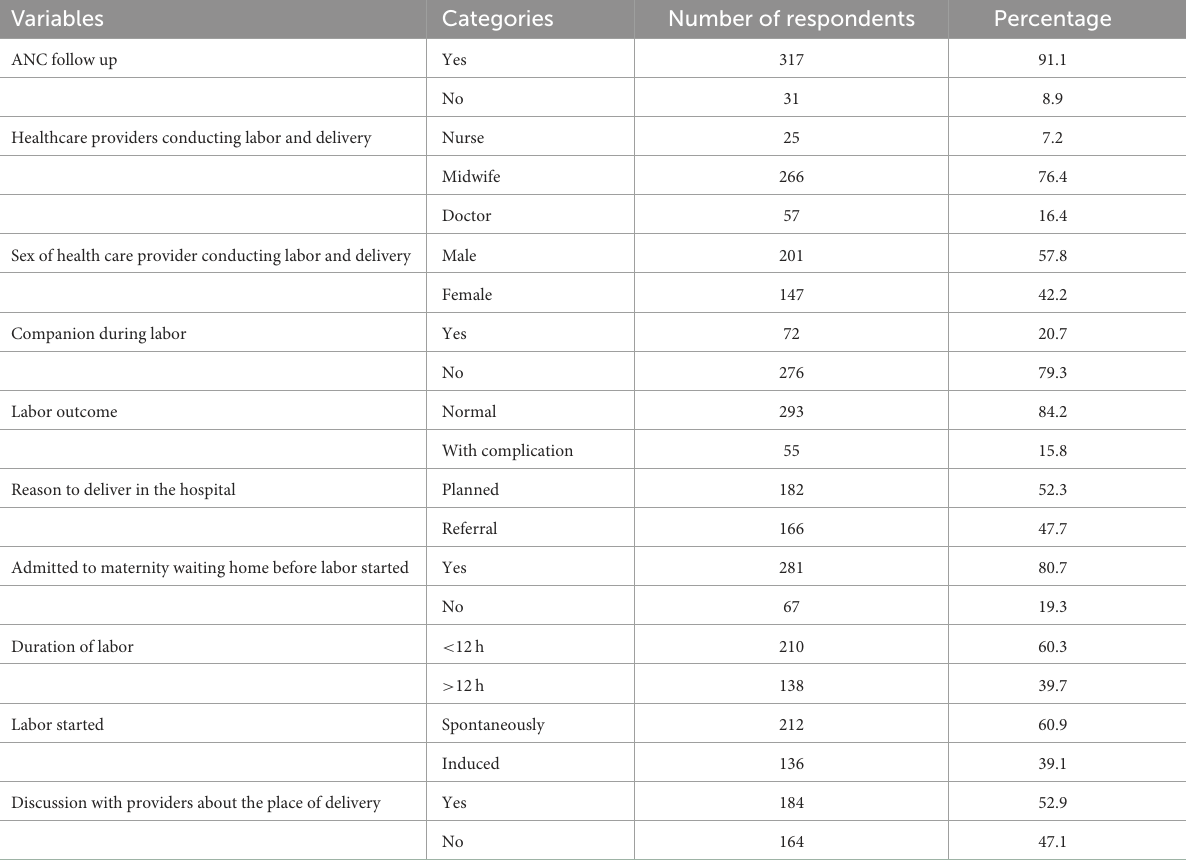
TABLE 2 The obstetric characteristics of mothers in three public hospitals in Southwest Ethiopia in 2021 ( n = 348).